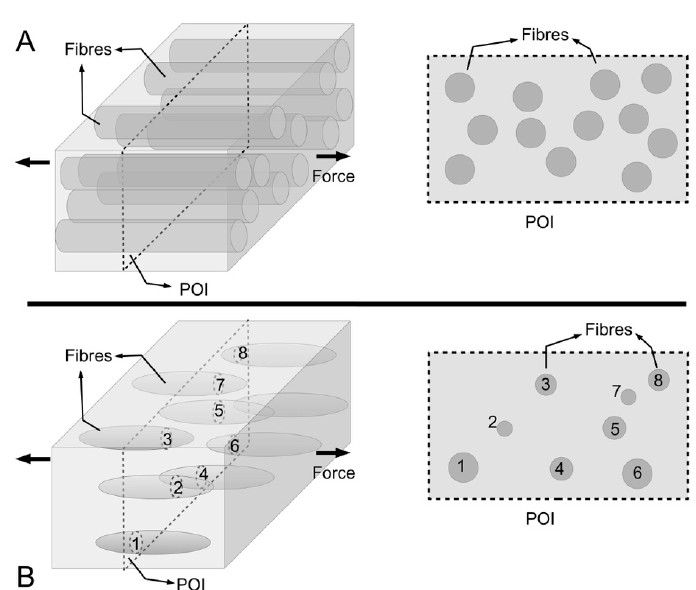
Figure 9. Schematics of the cross section of fibre reinforced composites. ( A ) Continuous uniform cylindrical fibre reinforced composite ( left panel ) from a 3D perspective. Corresponding 2D perspective showing the plane of interest (POI) containing the cross-sections of the uniform cylindrical fibre ( right panel ); ( B ) Discontinuous paraboloidal fibre reinforced composite ( left panel , 3D perspective). Corresponding plane of interest (POI) showing the cross-sections of the paraboloidal fibre ( right panel , 2D perspective). The fibres numbered, 1–8, in the 3D and 2D schematics are intended to illustrate their associations between the two views. In part ( A , B ), the force acting on the respective composites is in the direction of the fibre axis.